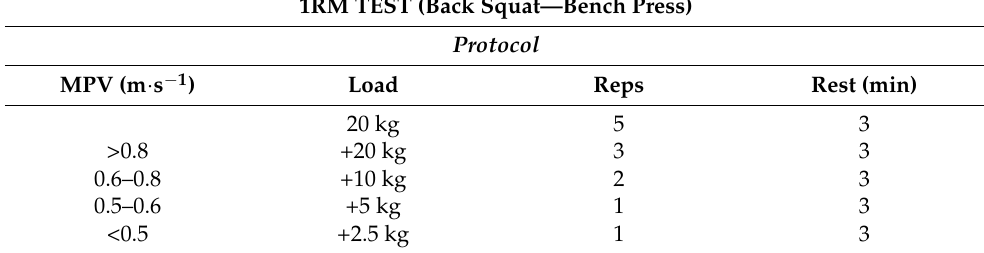
Table 2. Maximal incremental test